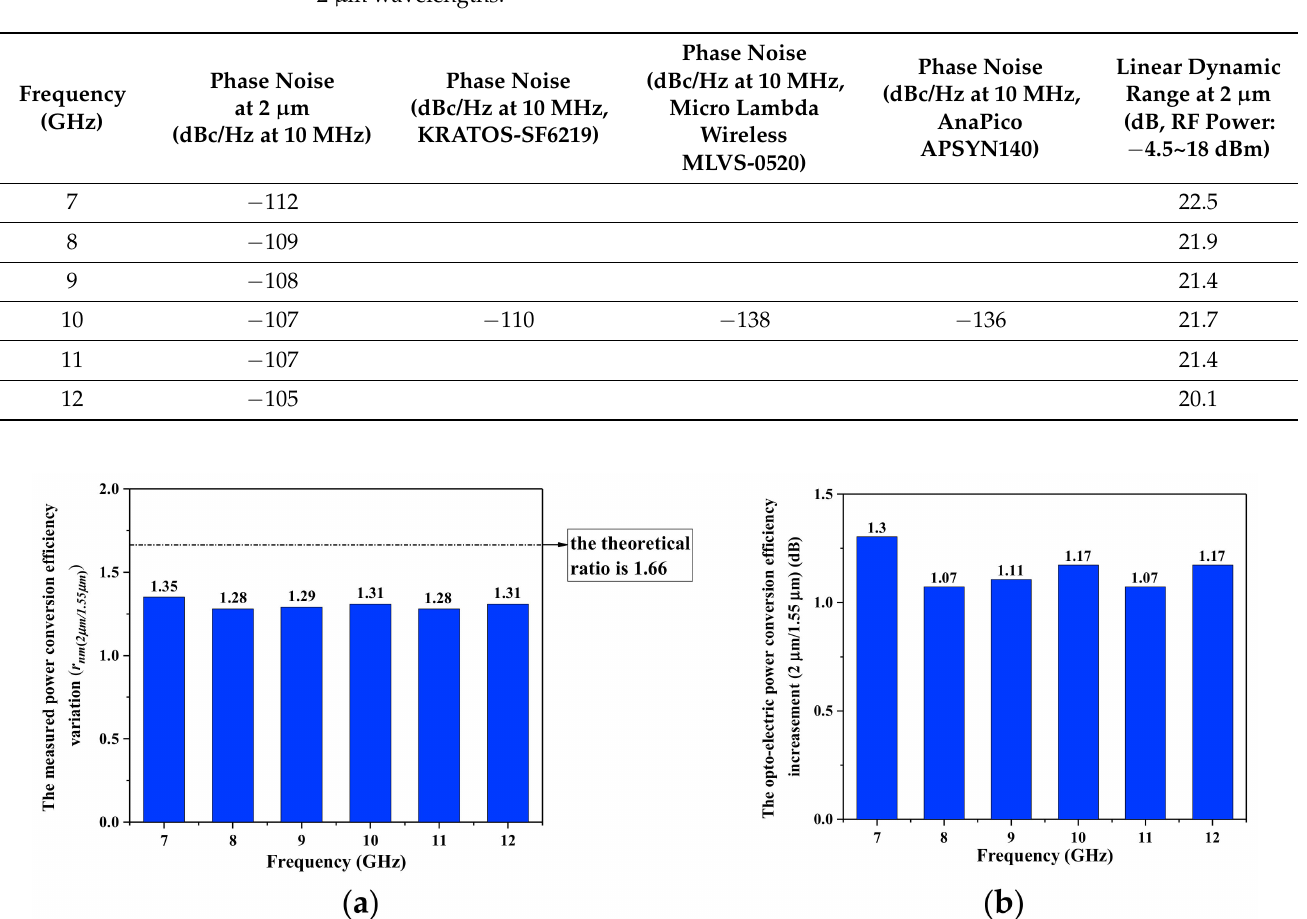
Table 1. The phase noise and linear dynamic range of the 7–12 GHz microwave carriers at 2 µ m wavelengths.